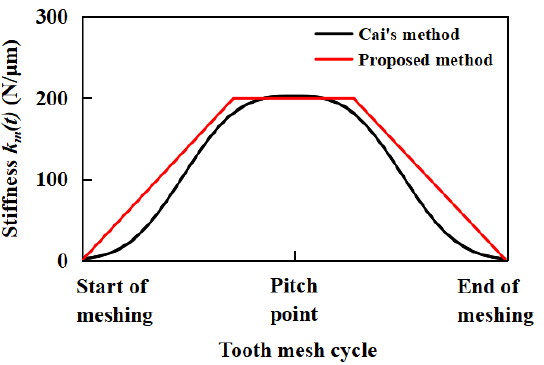
Figure 3. Single tooth meshing stiffness comparison between Cai’s method and proposed method.